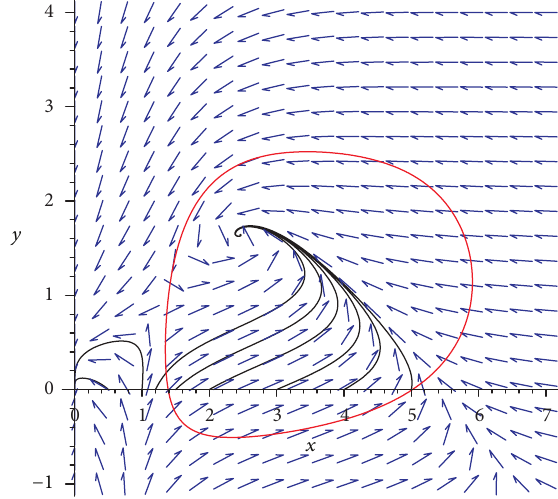
Figure 5: The DOA when 𝑎 = 12 for model